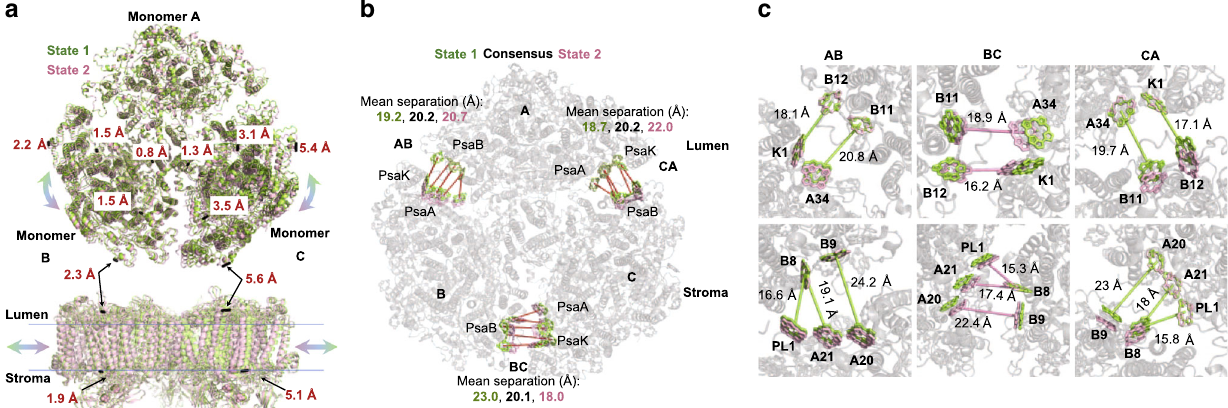
Fig. 7 Large-scale heterogeneity in PSI. a Two states, each representing 15% of the particle population are shown from the lumen in green and pink. Monomer A was superposed and several distances between state 1 and 2 are shown as black lines (top). Below is a side view of the same model showing distances measured on opposite sides of the membrane, showing that the movement is nearly parallel to the membrane plane. b Two Chl clusters from each state are shown on the background of the Red_a consensus model in gray. The state 1 and 2 con fi gurations of these Chls are shown in green and pink, respectively. The average distances between each cluster for state 1, Red_a and state 2 are shown at each monomer-monomer interface (labeled AB, BC, and CA). c The Chl con fi gurations at the three monomer interfaces, on both sides of the membrane, viewed from the luminal side. The distances of the closest state in each interface are shown and colored according the state (state 1 in green and state 2 in